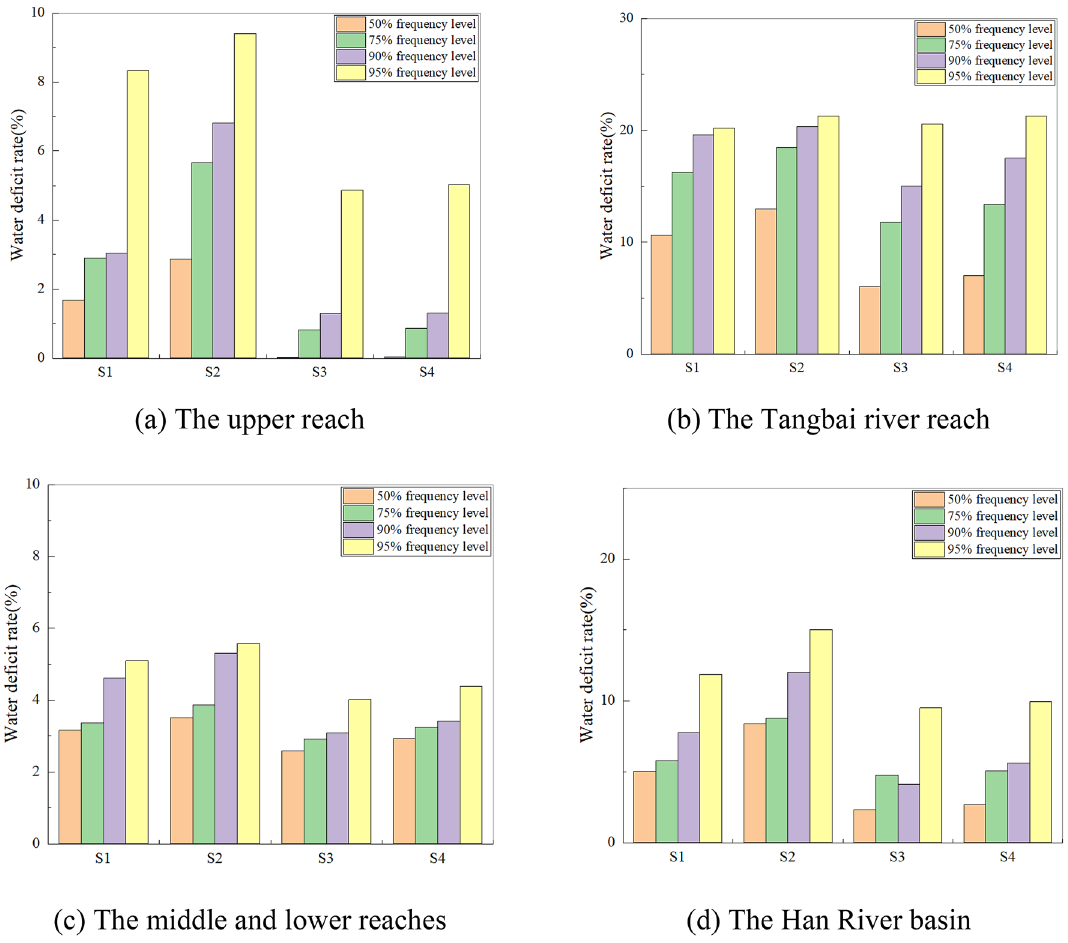
Figure 7. Water shortage rate in different water users under different